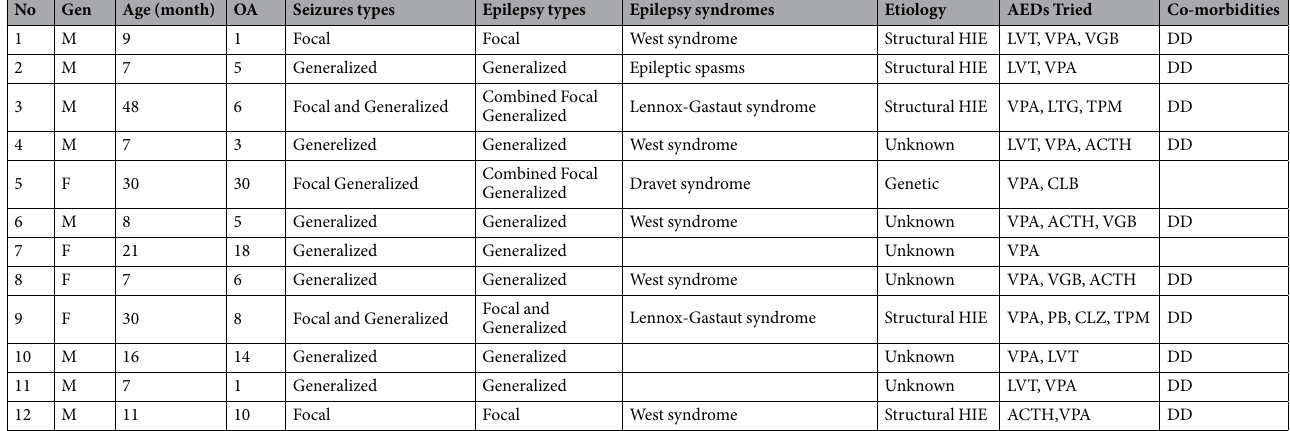
Table 1. Clinical characteristics of epilepsy group (EG 1 ) with seizures. Abbreviation: No – patient